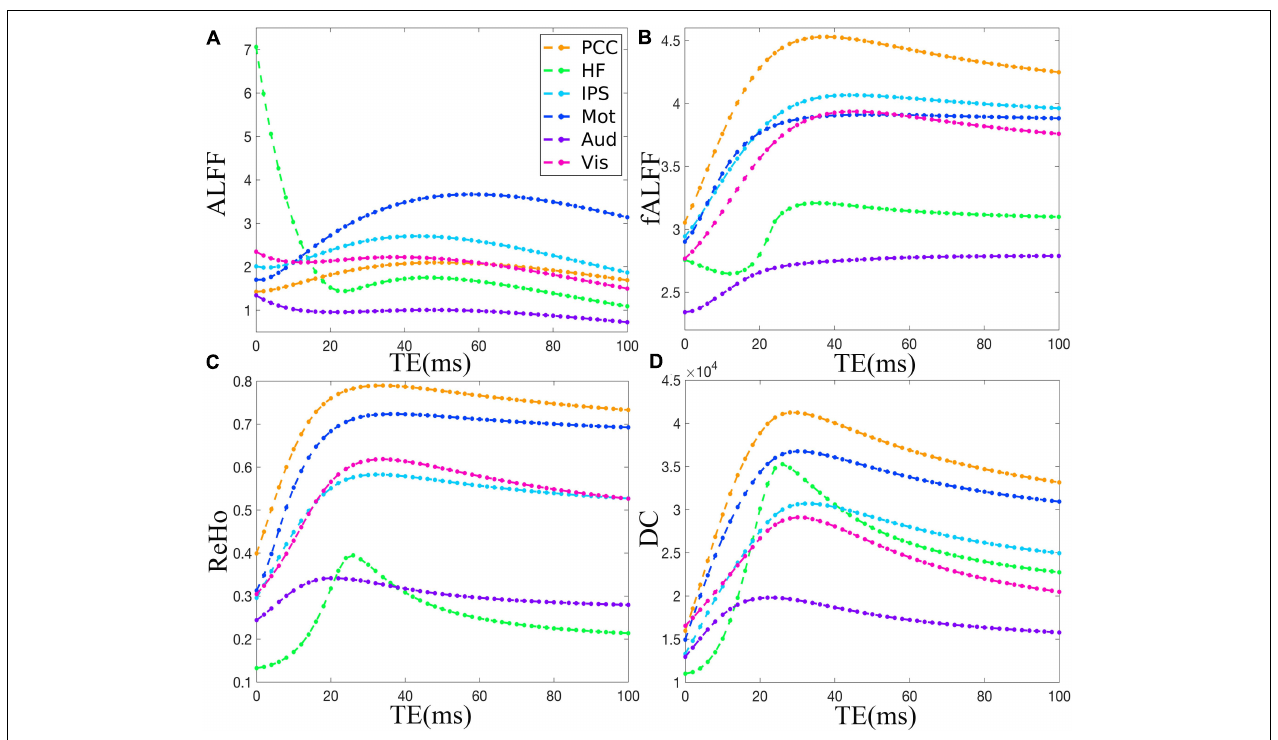
FIGURE 2 | The simulation of the TE dependency of ALFF (A) , fALFF (B) , ReHo (C) , and DC (D) of six representative ROIs, i.e., PCC, HF, IPS, Mot, Aud, and Vis, from a dataset under eyes closed condition. ALFF, amplitude of low-frequency fluctuation; fALFF, fractional ALFF; ReHo, regional homogeneity; DC, degree centrality; ROIs, regions of interest; PCC, posterior cingulate cortex; HF, left hippocampal formation; IPS, left intraparietal sulcus; Mot, left primary motor cortex; Aud, left auditory cortex; Vis, left primary visual cortex.